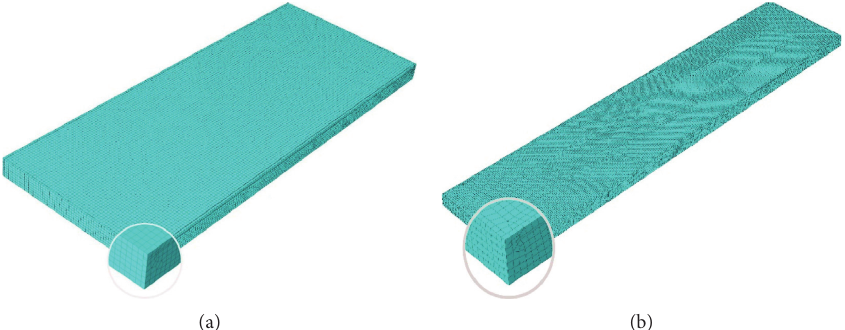
Figure 19: Second FE model (general models). (a) Single-span simply supported formwork. (b) Three-span continuous formwork.